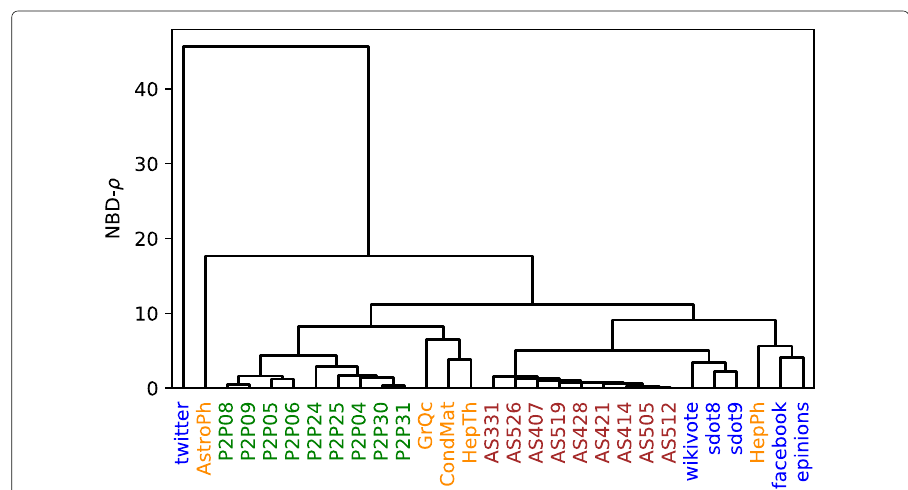
Fig. 10 Hierarchical clustering of real networks. Dendrogram showing hierarchical clustering (average linkage) of all real networks in our data sets. twitter is an outlier because, we hypothesize, it has more than twice as many edges (1.3M) as the second largest graph in our data sets ( sdot9 with 581k